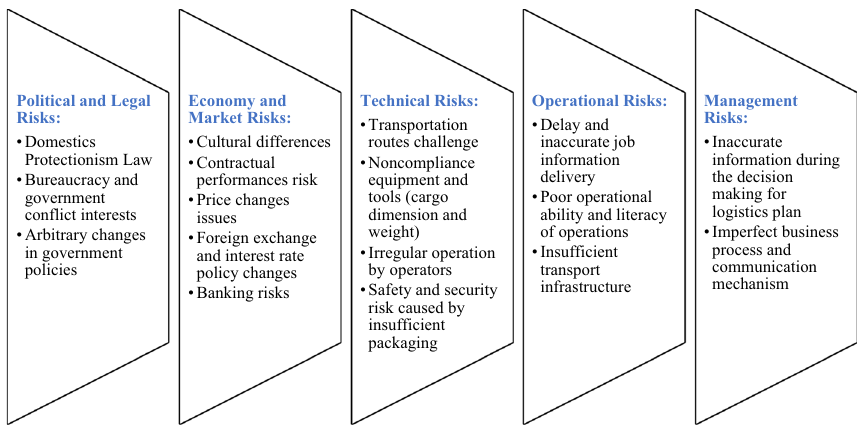
Fig. 4 Logistics risk for overseas EPC projects (He and Han 2022) (Palšaitis and Petraška